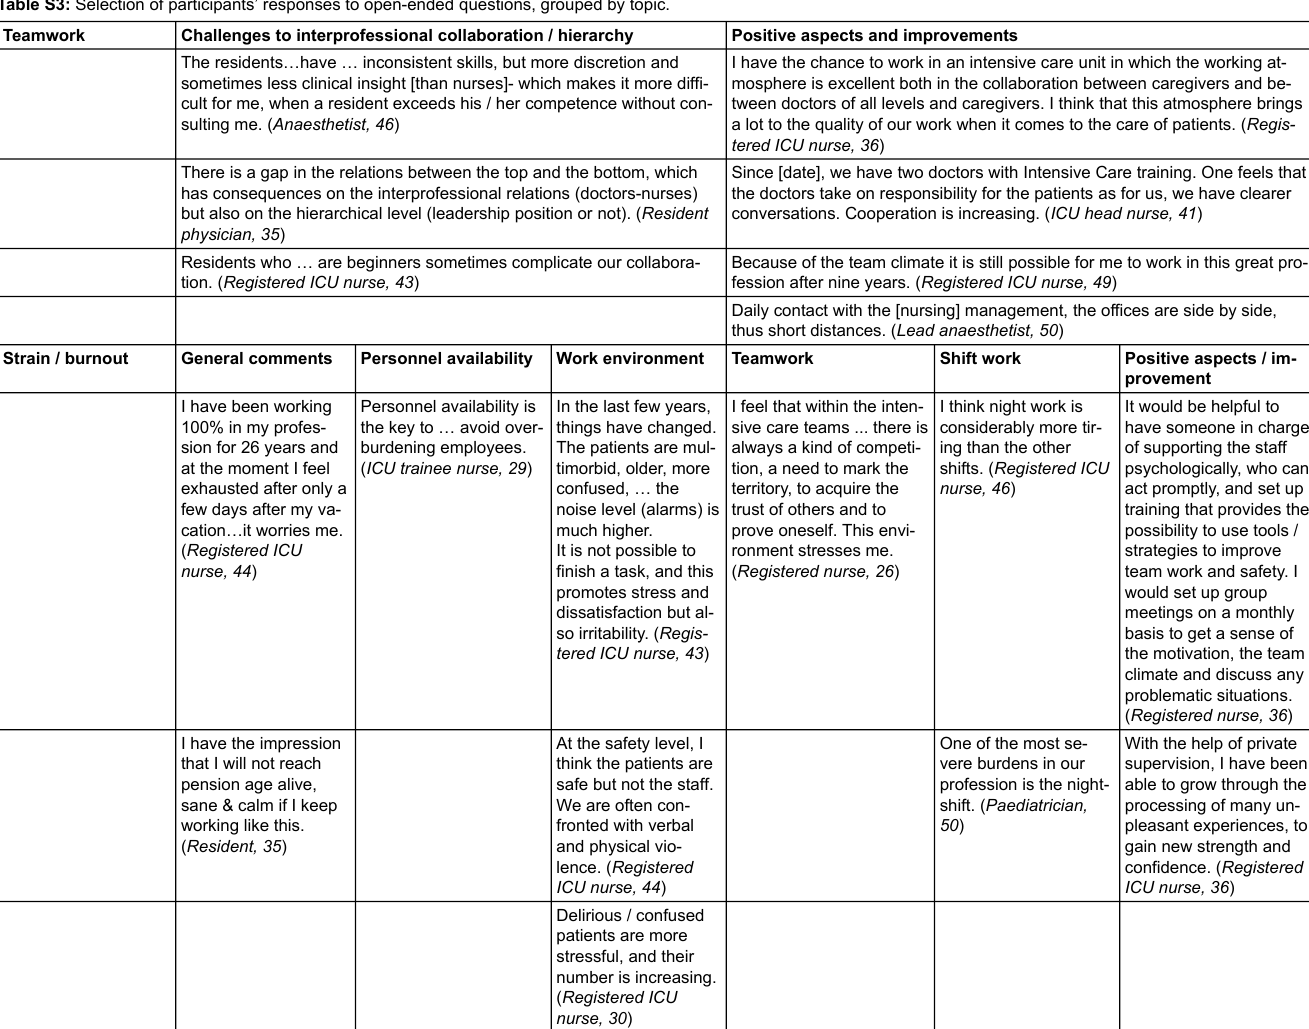
Table S3: Selection of participants’ responses to open-ended questions, grouped by topic.